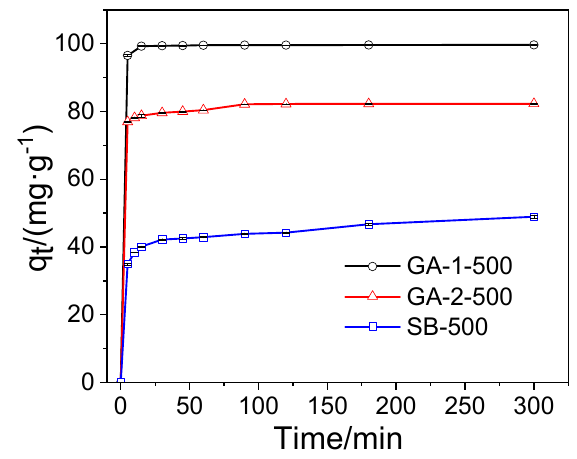
Figure 7. E ff ect of adsorption time on phosphorus removal. Figure 7. Effect of adsorption time on phosphorus removal. Table 1. Kinetic model parameters of phosphorus adsorption on alumina